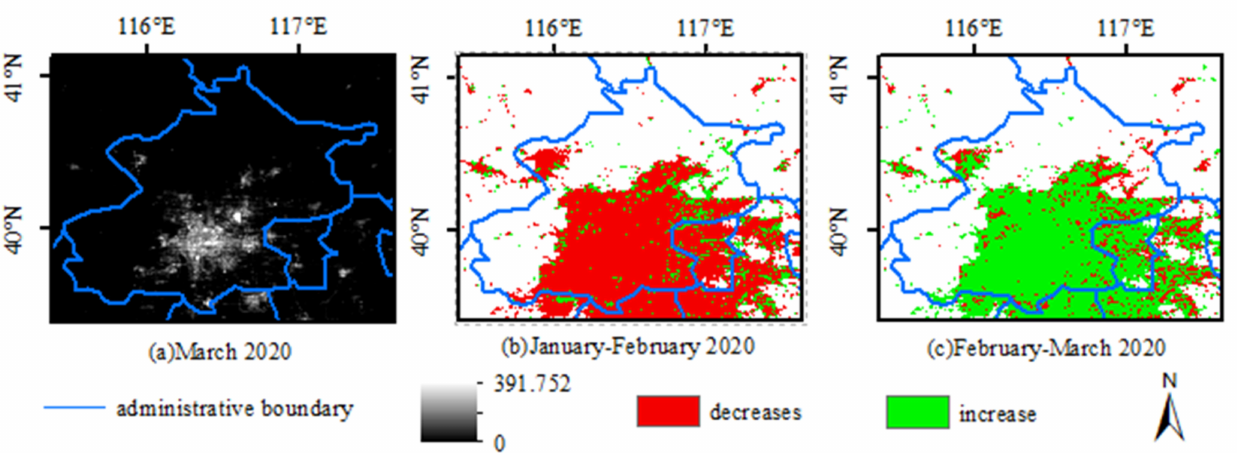
Figure 1. The change of NTLs in Beijing from January 2020 to March 2020. ( a ) VIIRS monthly composite NTLs image in